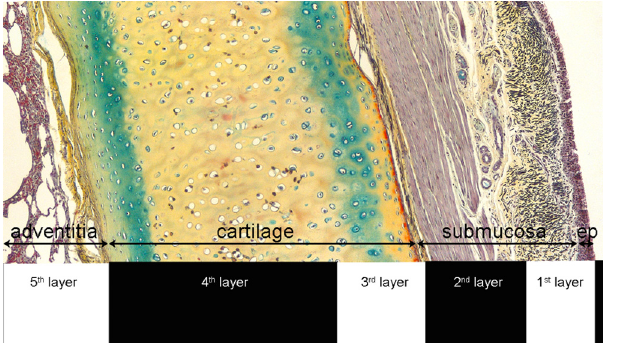
Fig 4. Comparison of EBUS and histological composition of equine airways. In absence of cartilages, L3 was represented by the adventitia.